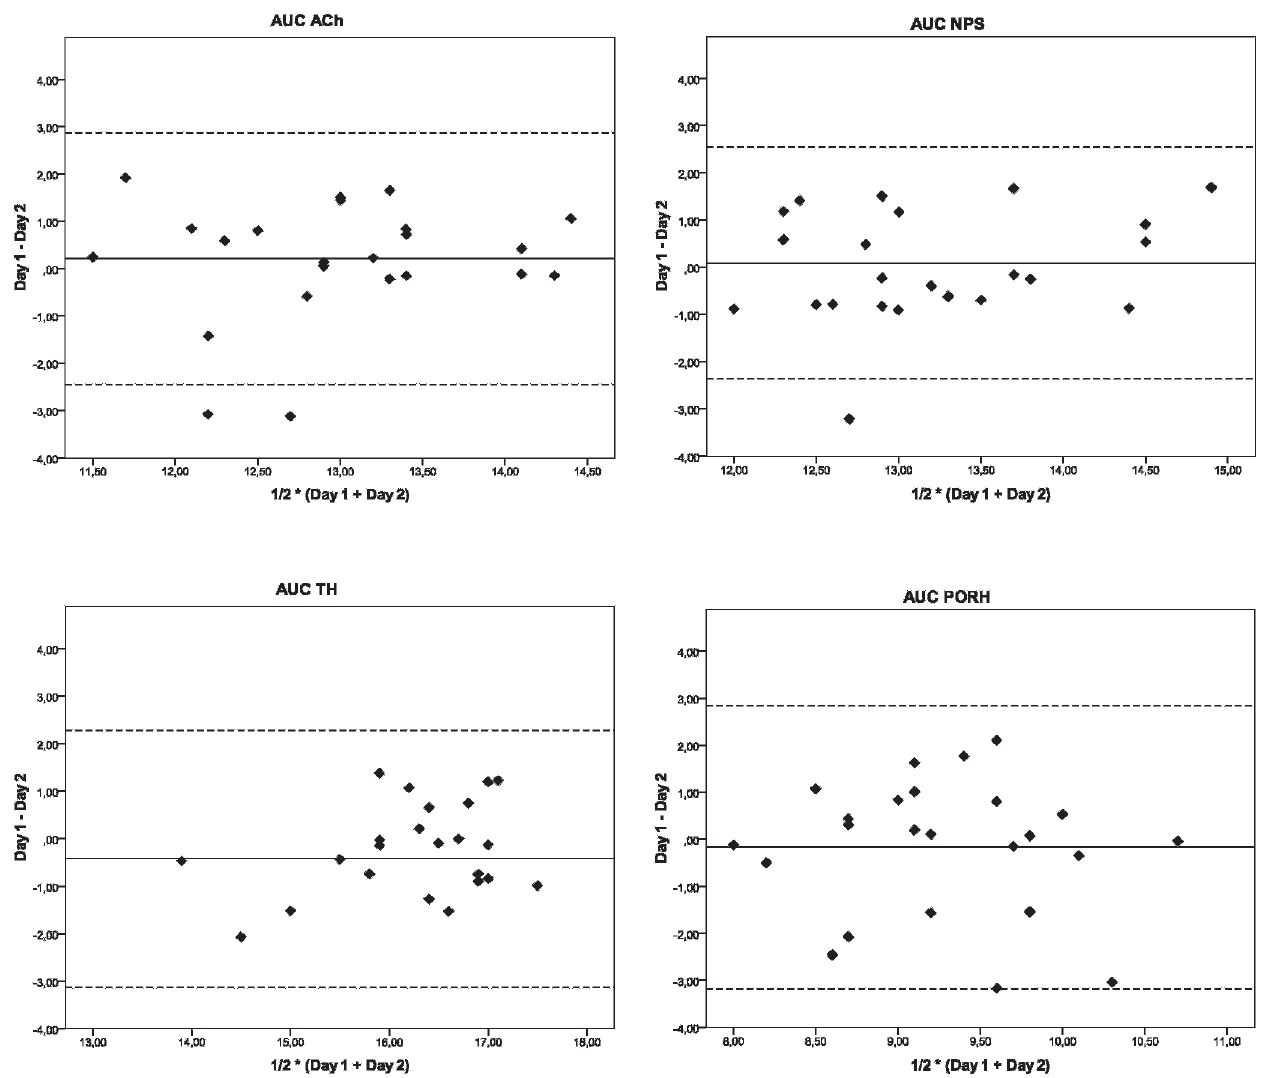
Figure 1 - Bland-Altman plots for the assessment of the day-to-day repeatability of microvascular reactivity measurements obtained one week apart in healthy subjects using laser Doppler perfusion monitoring. The difference in the responses measured on the two days (Day 1– Day 2) is plotted against the average of the responses [ K * (Day 1 + Day 2)]. The solid lines correspond to the mean of the differences, and the dashed lines indicate the 95% limits of agreement for the differences between the days. The values were log- transformed. Ach = acetylcholine, AUC = area under the blood flow/time curve, SNP = sodium nitroprusside, PORH = post-occlusive reactive hyperemia, and TH = thermal